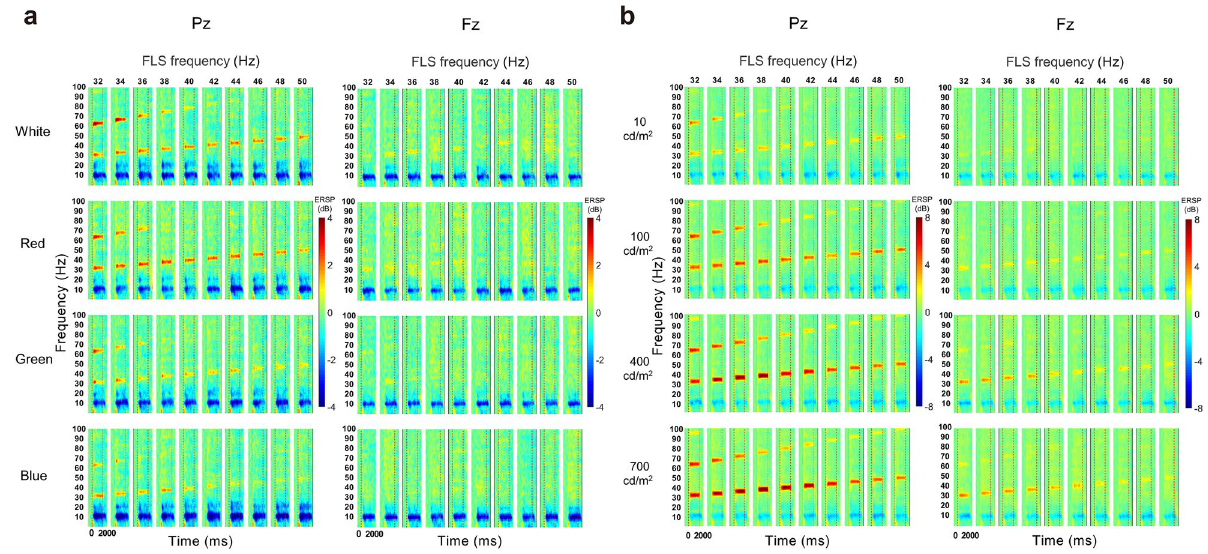
Figure 1. Grand-average ERSP of SSVEP induced by flickering light stimulus (FLS). Each column shows ERSP from 750 ms before the onset of FLS to 750 ms after the offset of FLS. ( A ) Comparison of grand-average ERSPs between colors. ( B ) Comparison of grand-average ERSPs between luminance